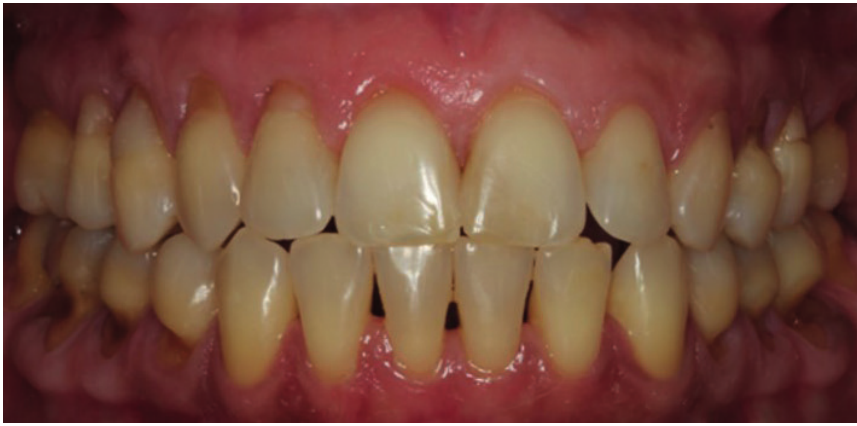
Figure 1. Preoperative frontal view. Note the presence of a non-carious cervical lesion on the maxillary central incisor, the right lateral incisor, and the left premolar. Old resin restorations on right canines, left and right premolars showed ill-fitting